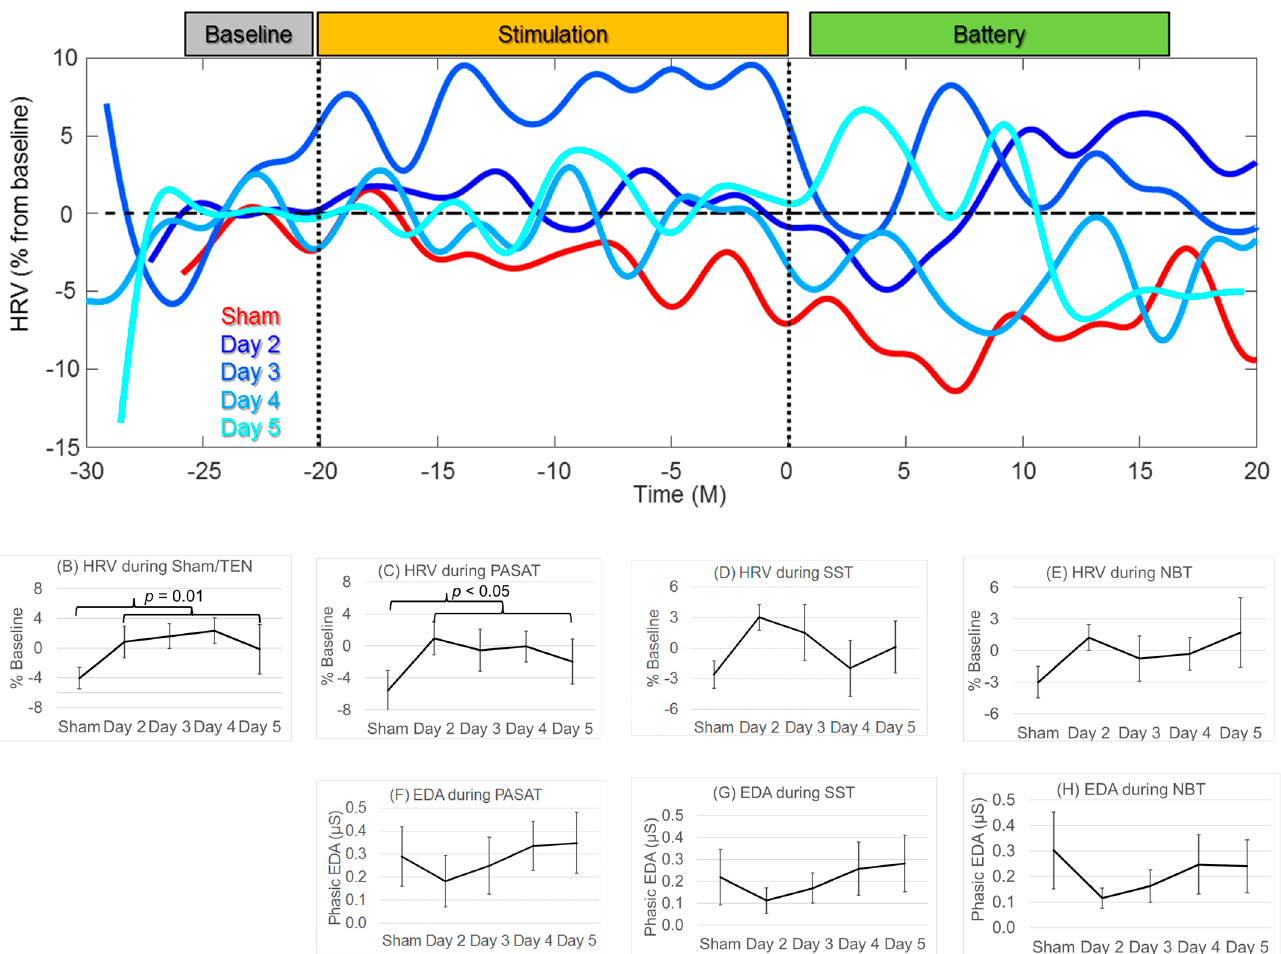
Figure 6. The effect of TEN on HRV and EDA. Mean and standard error bars are shown. The increase in HRV is shown for ( A ) an example individual, ( B ) across the group for the time period of the sham/TEN and ( C – E ) and for the anxiety- provoking tasks. HRV was significantly higher (improved) during TEN sessions as compared to the sham during the ( B ) stimulation and ( C ) the PASAT (shown as black brackets). EDA during ( F – H ) anxiety-provoking tasks decreased after the sham, but did not reach significance at the group level. No EDA was computed during the